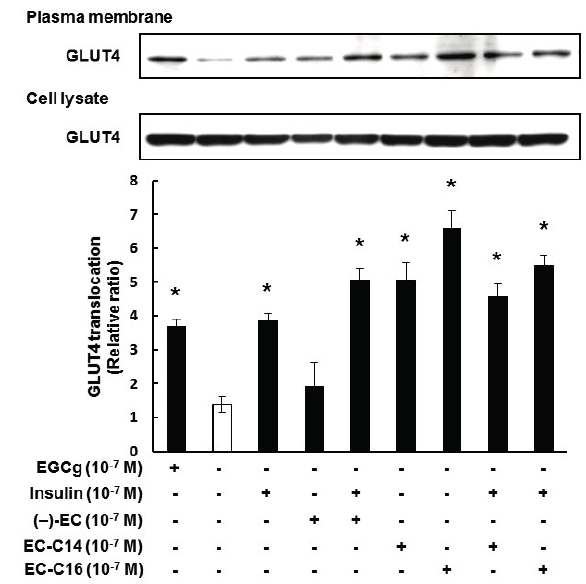
Figure 4. The dose-dependent effects of 3- O -acyl-( − )-epicatechins on GLUT4 translocation in L6 myotubes. Differentiated L6 cells were incubated with 3- O -acyl-catechins at the indicated concentrations for 15 min. GLUT4 in the plasma membrane and the cell lysate were detected by Western blot analysis. Band density was determined by ImageJ analysis software. Data are shown as the mean ± SE ( n = 3). * p < 0.05 vs. DMSO-treated control cells by a Dunnett multiple comparison test.